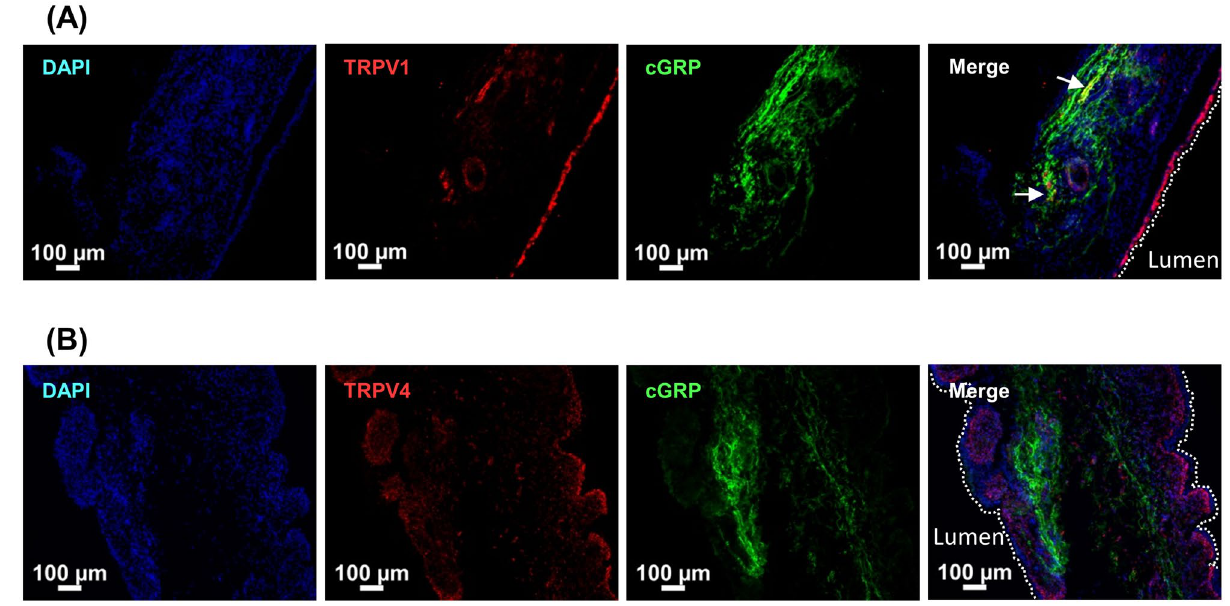
Figure 3. Representative results of immunofluorescence localization of TRPV1 ( A ) and TRPV4 ( B ) in mild KC bladder specimens. Double immunofluorescence of TRPV1 or TRPV4 (red) with CGRP (green) was performed. Nuclei were labeled with DAPI (blue). TRPV1-positive nerve fibers are indicated by arrows. Dashed white lines indicate the apical surface of the umbrella cells. The double immunochemical staining revealed that the lack of co-expression with CGRP for TRPV4, and the expression of TRPV1 in only a few nerve fibers.